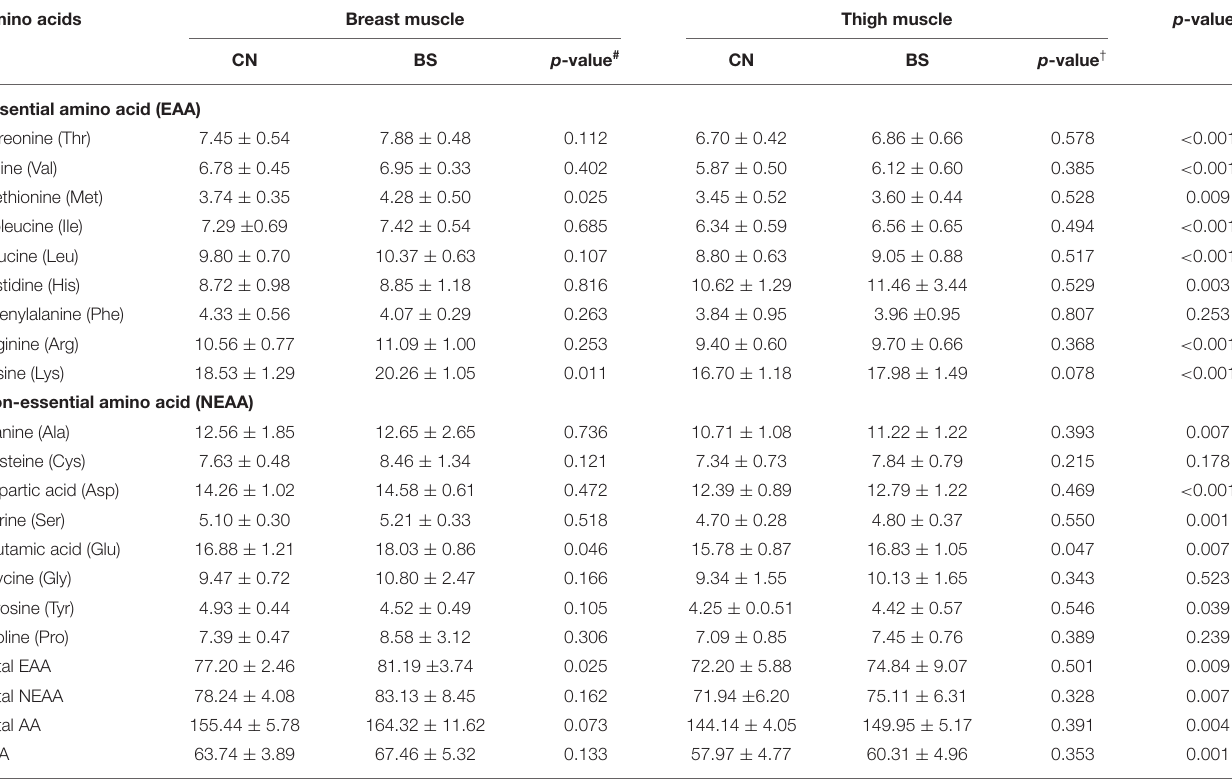
TABLE 5 | Effects of Bacillus subtilis supplementation on amino acid content in breast muscle and thigh muscle of broiler chickens (mg/100g DM). Amino acids Breast muscle Thigh